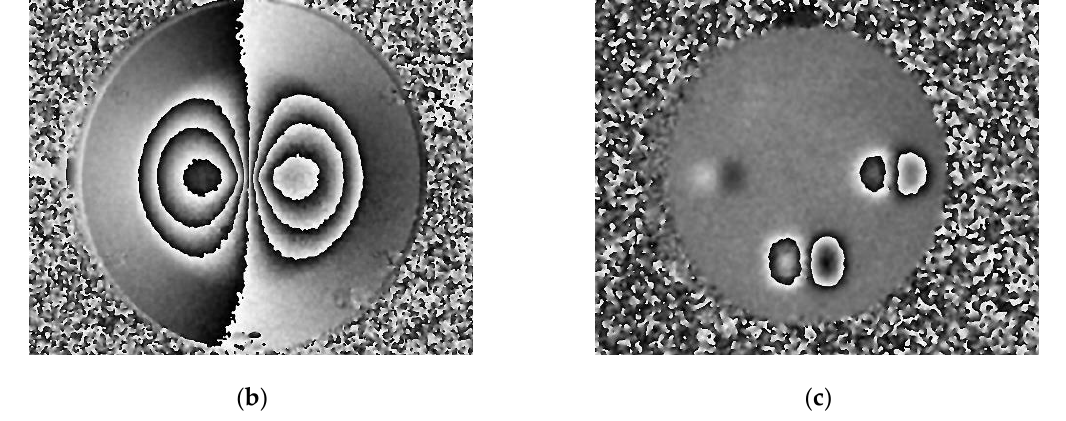
Figure 14. ( a ) The new shearography system with a spatial light modulator; ( b ) experimental result of a thimble-loaded aluminum plate; ( c ) experimental result of a composite plate with three flaws.